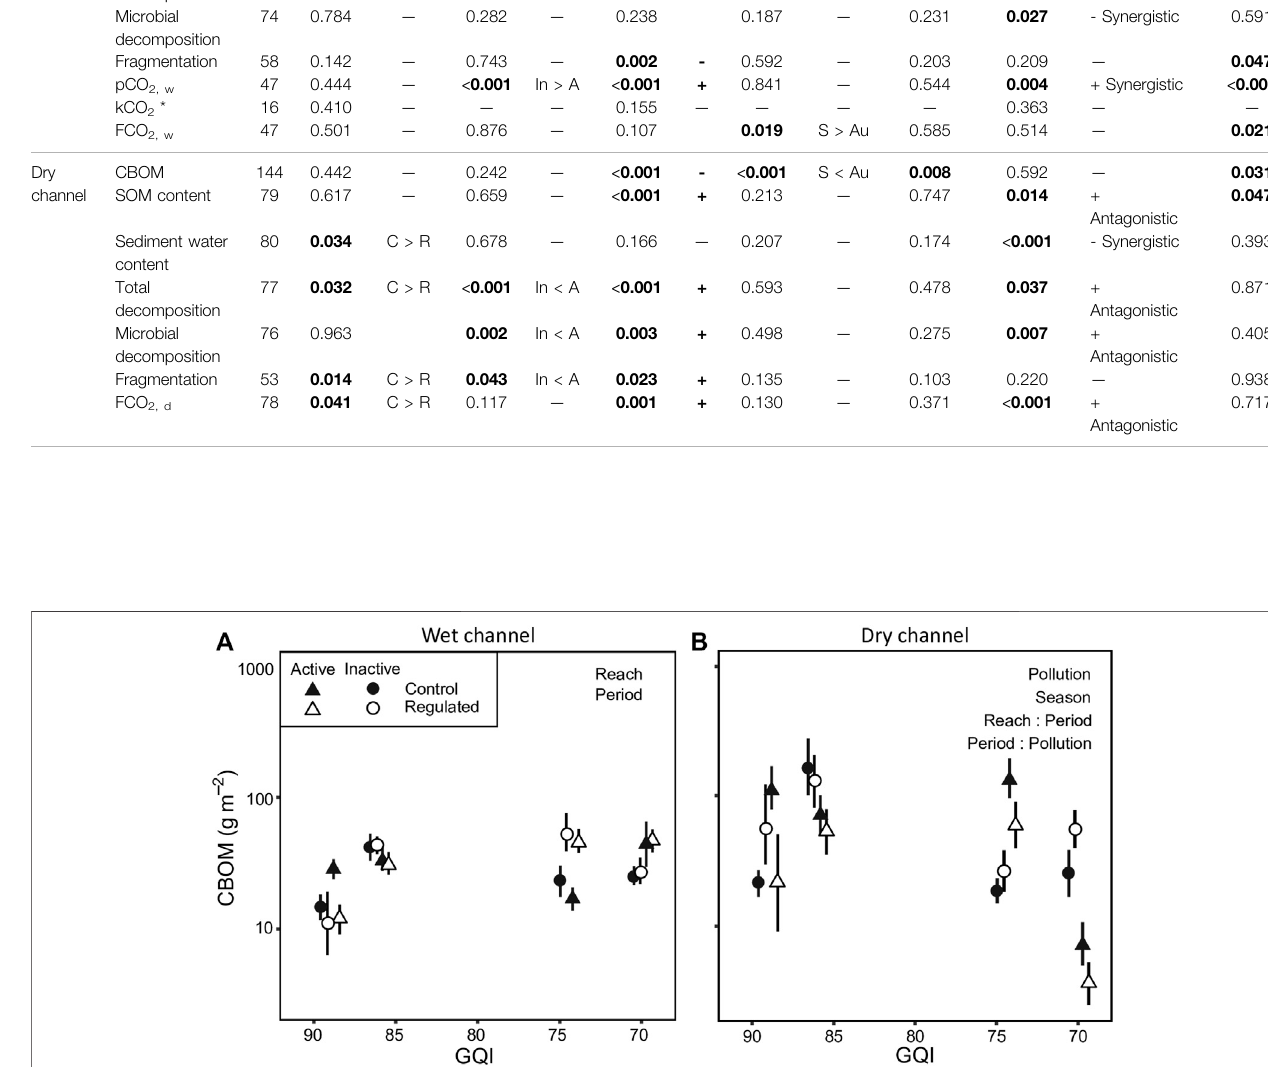
Microbial decomposition